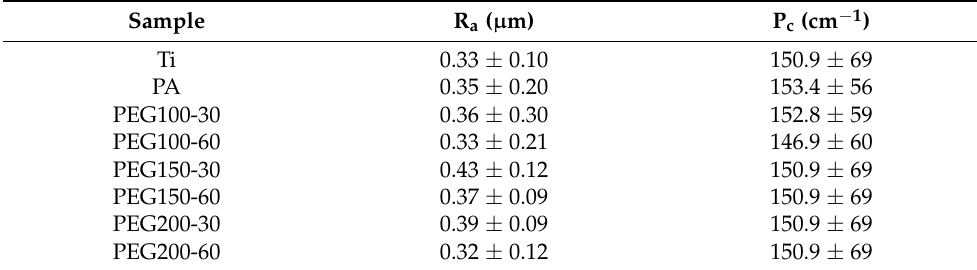
Table 2. Roughness of the different mini-implants.